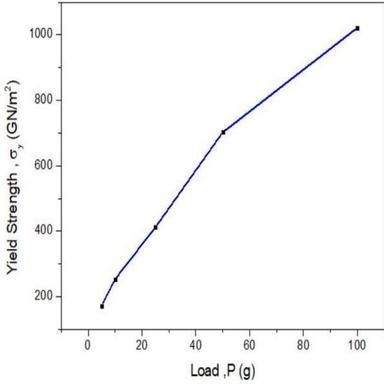
Load (P) vs Yield strength (σy) – G4C3NBM.